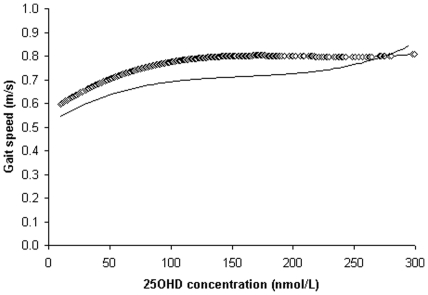
Loess regression plots gait speed (meter/seconds) by 25-hydroxyvitamin D (25OHD) concentrations; straight line–for women and diamond line ◊◊ for men.